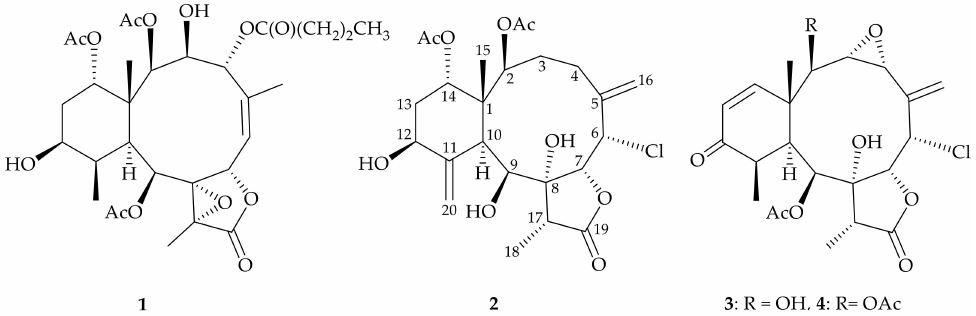
Figure 1. Structures of briaexcavatolide P ( 1 ), briastecholides B ( 2 ) and C ( 3 ), and briarenol R ( 4